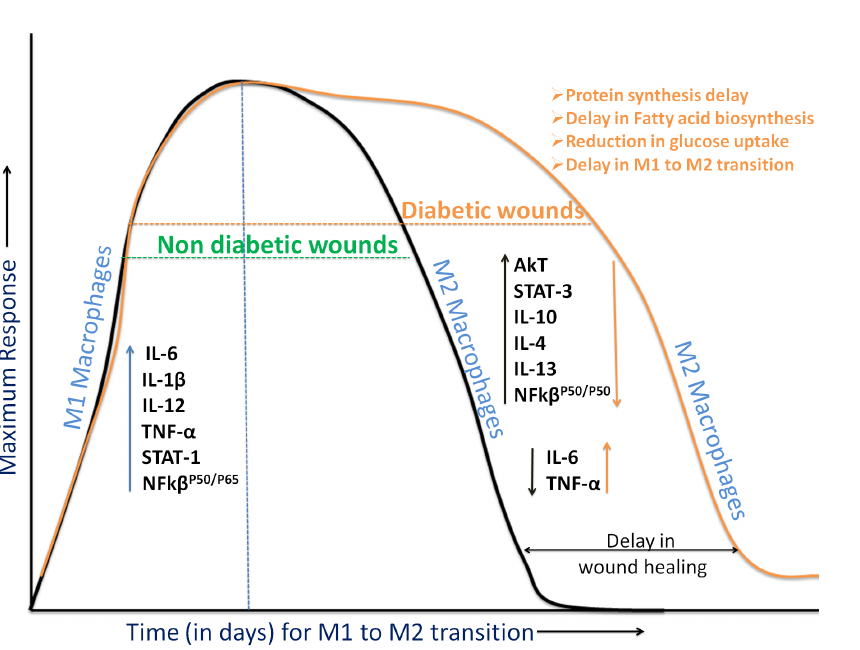
Figure 1: M1 (classically activated) macrophages, like IL-10, IL-1β, IL-12, TNF-α, STAT1 and NFkβ P50/P65 , are responsible for inflammation at the wound site. M2 macrophages, like PKC, HIF-α, STAT3, NFkβ P50/P50 etc, help in wound recovery by reducing the inflammation. Patients having